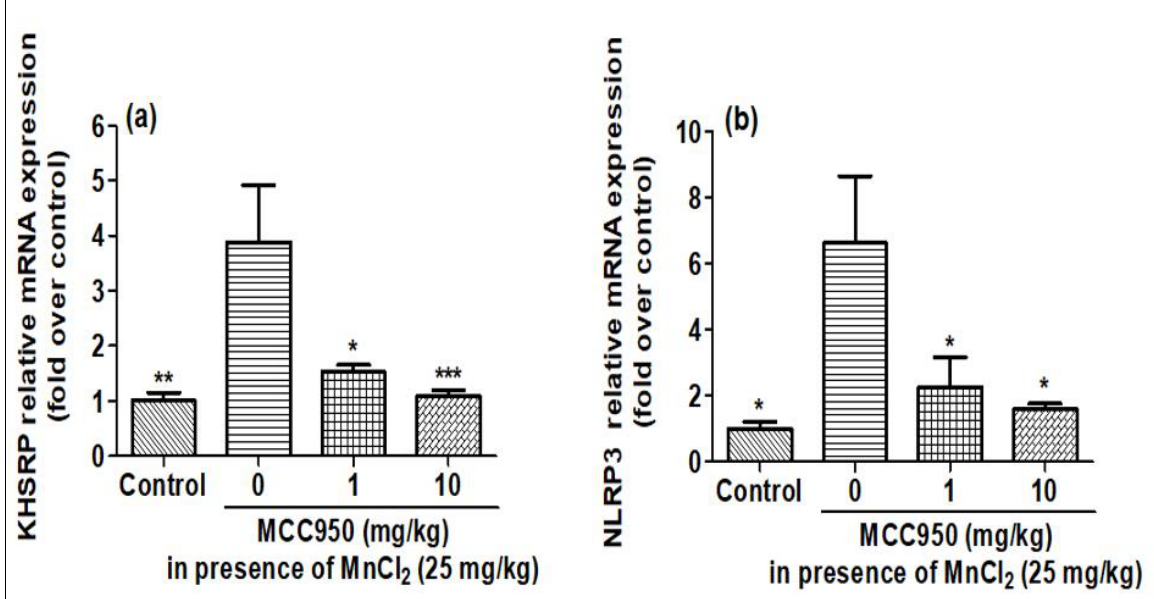
Figure 8. MnCl 2 was able to overexpress the KHSRP and NLRP3 mRNA expression, which was controlled in a dose-dependent manner by MCC950 in rat brain samples detected by qPCR. ( a ) relative KHSRP mRNA expression, ( b ) relative NLRP3 mRNA expression. All mRNA values were normalized to the housekeeping mRNA, GAPDH, and expressed as a fold-induction over the control sample (set at a value of 1). Data represented as mean ± SEM. * p < 0.05, ** p < 0.001, *** p < 0.0001 vs. control group.